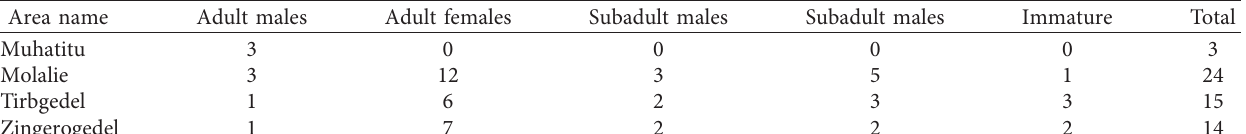
Table 1: Total number of geladas counted in each site with different age and sex groups.